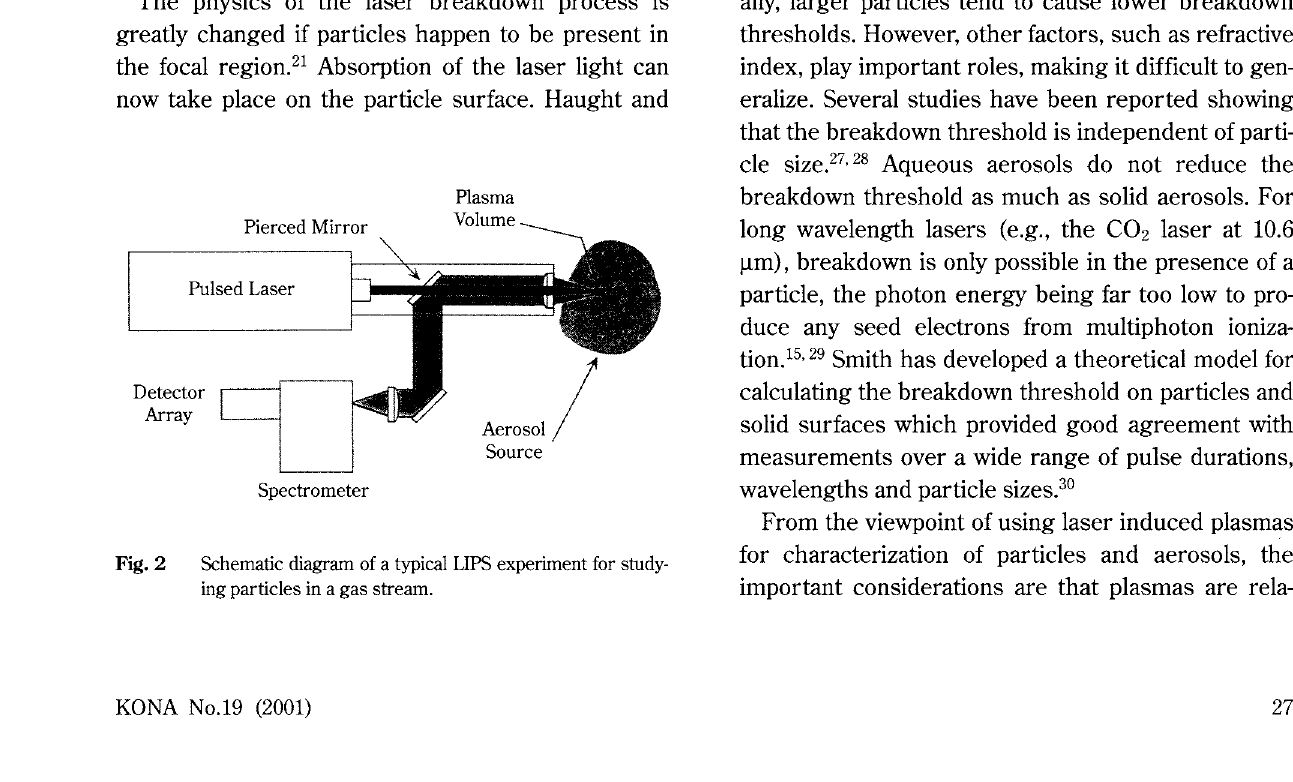
Fig. 2 Schematic diagram of a typical LIPS experiment for study ing particles in a gas stream.